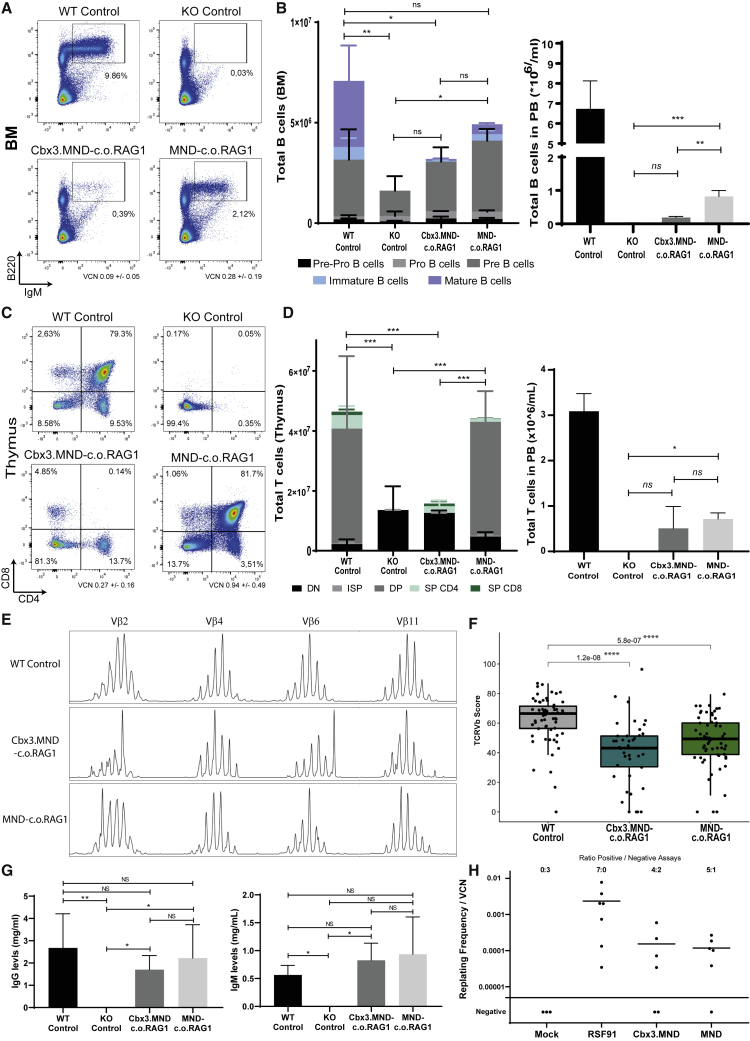
Selecting the Optimal SIN LV Plasmid to Drive an Immune Reconstitution of Rag1 DeficiencyRag1-deficient mice (experiment with a total of 3 mice/group) were transplanted with 500,000 stem cells: WT cells, mock Rag1 KO cells, Cbx3.MND-c.o.RAG1-treated KO cells (VCN of 0.95), and MND-c.o.RAG1-treated KO cells (VCN of 1.1). (A) Representative FACS plots showing the restoration of B220high+ B cells in the BM. (B) Total number of the different B cell subsets in the BM (left panel) and total number of B cells (B220high+) in the PB (right panel) 16 weeks after SC transplantation. Graphs represent the means and standard deviation of a pilot experiment with two to three mice per group (Mann-Whitney test, one-tailed; ∗p ≤ 0.05; NS, not significant). (C) Representative FACS plots of the thymus reconstitution (CD4 versus CD8) with the different constructs. (D) Total number of the different T cell subsets in the thymus (left panel) and total number of T cells (CD3+TCRαβ+) in PB (right panel) 16 weeks after transplantation. Graphs represent the means and standard deviation of a pilot experiment with two to three mice per group (Mann-Whitney test, one-tailed; ∗p ≤ 0.05; NS, not significant). DN, double negative; ISP, immature single positive; DP, double positive; SP, single positive. (E) Representative samples of GeneScan plots are shown for four different families (x axis indicates CDR3 length; y axis shows the fluorescence intensity of the runoff products). (F) TCR Vβ repertoire analysis by GeneScan. A total of 24 Vβ families were analyzed on spleen cells from three mice per group. Overall score of all of the families was calculated for the different constructs (Mann-Whitney test; p values are represented on the plot; ∗∗∗∗p < 0.0001; NS, not significant). (G) Quantification of total IgG and IgM in mice serum by ELISA (one-way ANOVA test; ∗p < 0.05, ∗∗p < 0.01). (H) IVIM assay was performed on the two constructs to assess their safety (mock cells as negative control; RSF91 γ-retroviral vector as a positive control). Data show results from three complete IVIM assays.